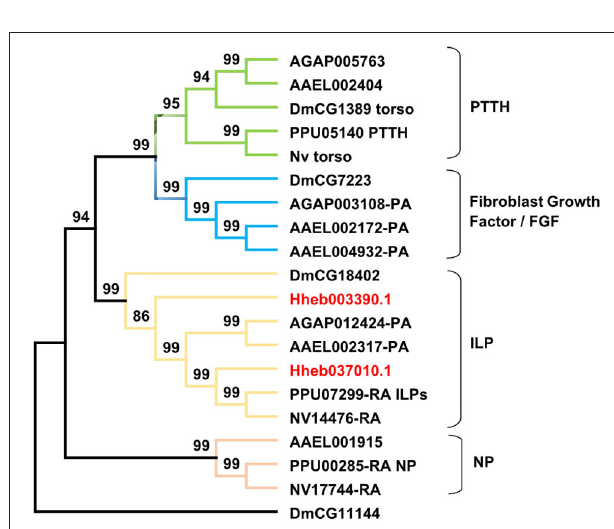
FIGURE 8 | Phylogenetic tree of RTKs (receptor tyrosine kinases) from H. hebetor (Hh), A. aegypti (AAEL), A. gambiae (AGAP), D. melanogaster (Dm), P. puparum (Pp), and N. vitripennis (Nv). The numbers at the nodes of branches indicate the posterior probability for each branch. The red labels are from H. hebetor . The amino acid sequences used are listed in the Supplementary Material File 7 .